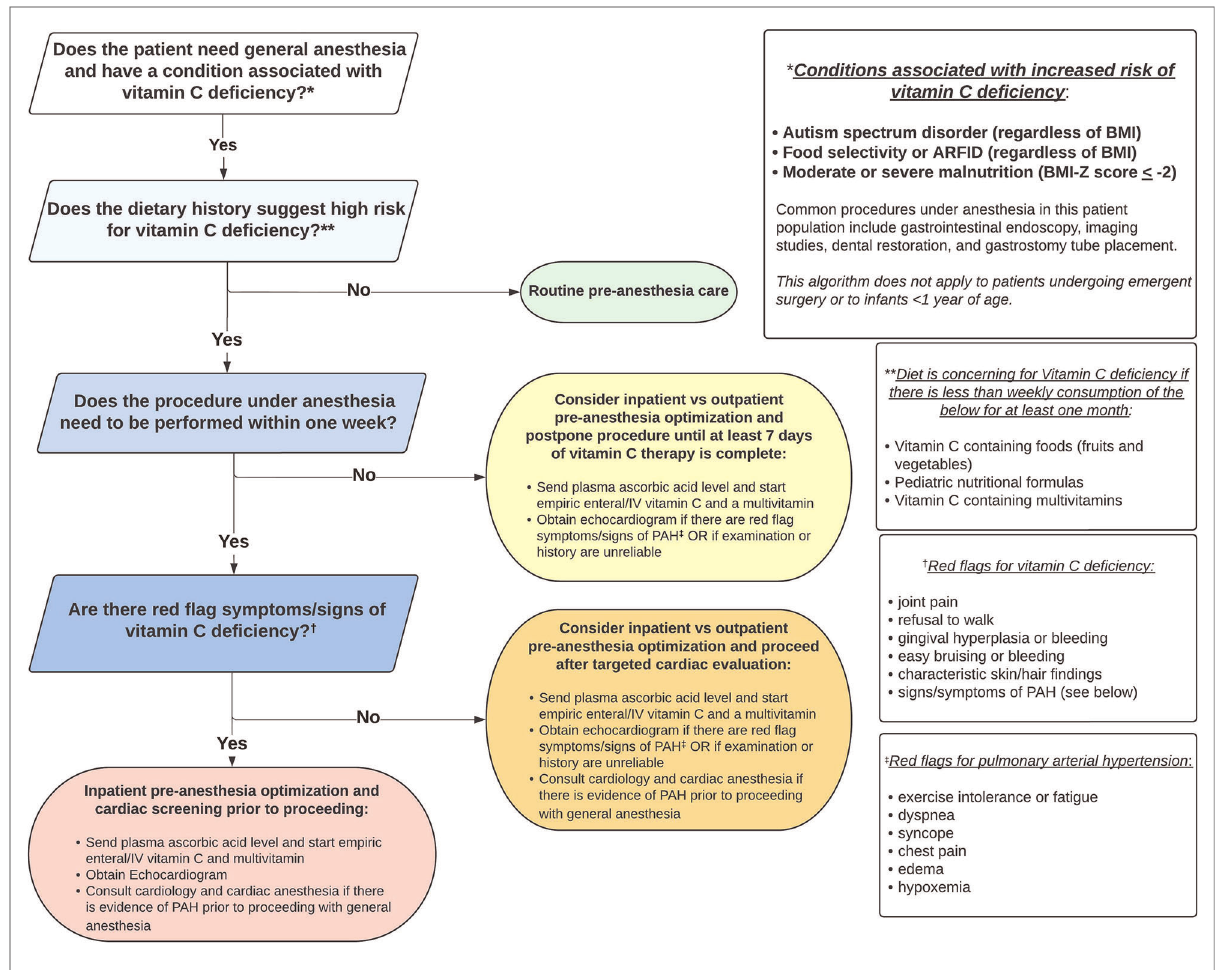
FIGURE 3 Approach to pre-anesthesia evaluation in patients at risk for vitamin C de fi